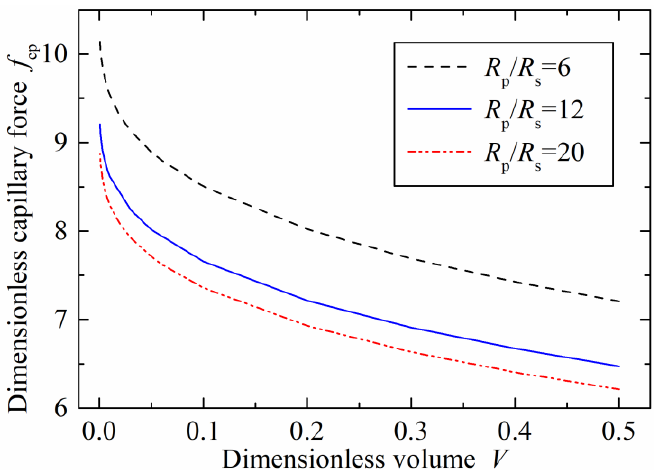
Figure 6. Effects of the dimensionless volume on the dimensionless capillary force.